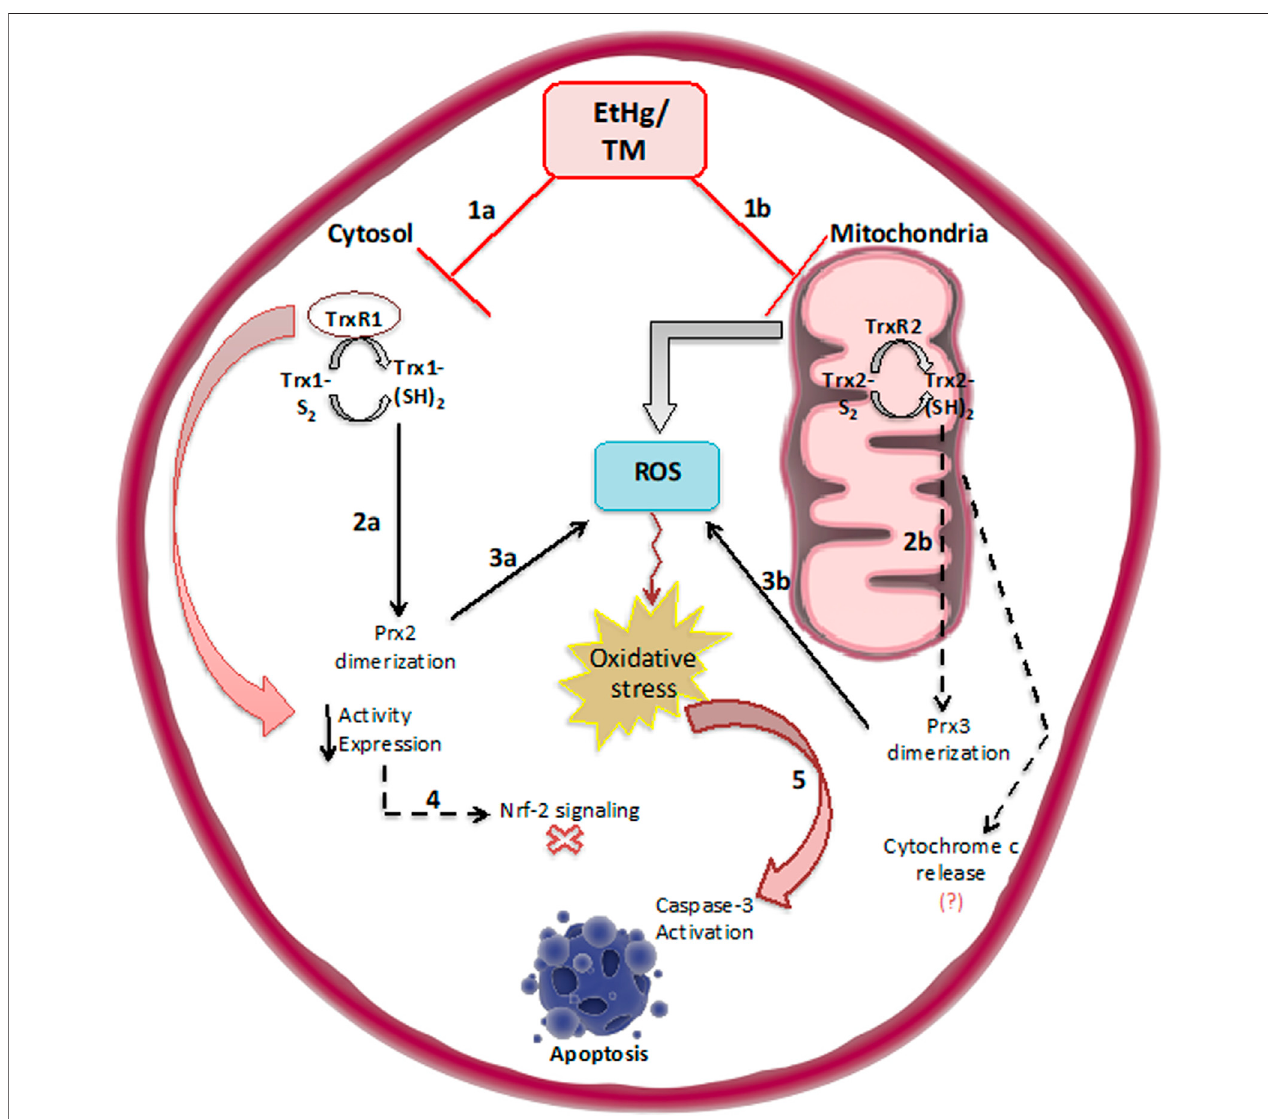
FIGURE6| Schematicillustration oftheeffectsofexposure toEtHg/TmHg ontheThioredoxinsystembothinthecytosol(TrxR1/Trx1)andinmitochondria(TrxR2/ Trx2)(1a,1b).AsaresultofTrxoxidationperoxiredoxinsaredimerized(2a,2b)causingareductioninantioxidantcapacityandaccumulationofROS(3a,3b).Atthesame time,thereduction inTrxR/Trxactivityandexpression likelypromotesNrf-2signalingasanattempt torecoverenzymaticactivitylevels(4).Overall,oxidationofTrx,leads to caspase-3 activation, and eventually, apoptosis takes place (5). Nevertheless, some of these mechanisms need to be further con fi rmed, so the dashed arrows refertothosemechanismssuchasanalyzingtheNrf-2signalingpathway,con fi rmingPrx3dimerization, andassociatedmoleculareventssuchascytochromecrelease, activation of caspase-8 and -9.